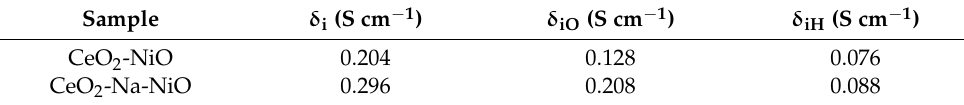
Table 2. The conductivities of the as-prepared materials at 530 ◦